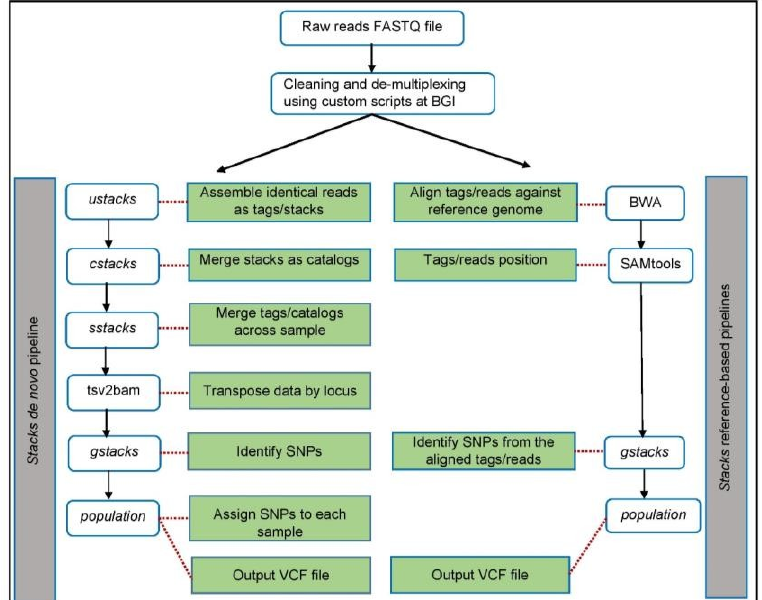
Figure 1. Comparison of de novo and reference pipelines. The horizontal boxes on the left side represent the programs in STACKS for a de novo pipeline. The horizontal boxes on the right side represent the programs in the STACKS for a reference pipeline. The green boxes in the middle represent potential program functions, while the dark red dotted lines specify the main function for each program in the two pipelines.